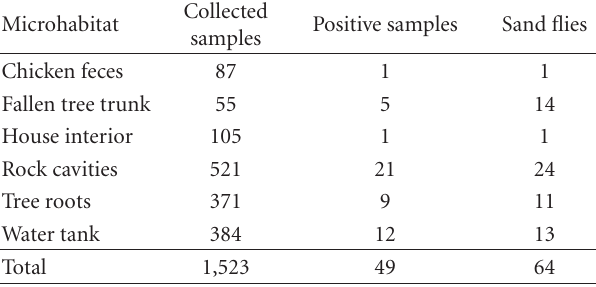
Table 1: Positive microhabitats and sand flies yield.